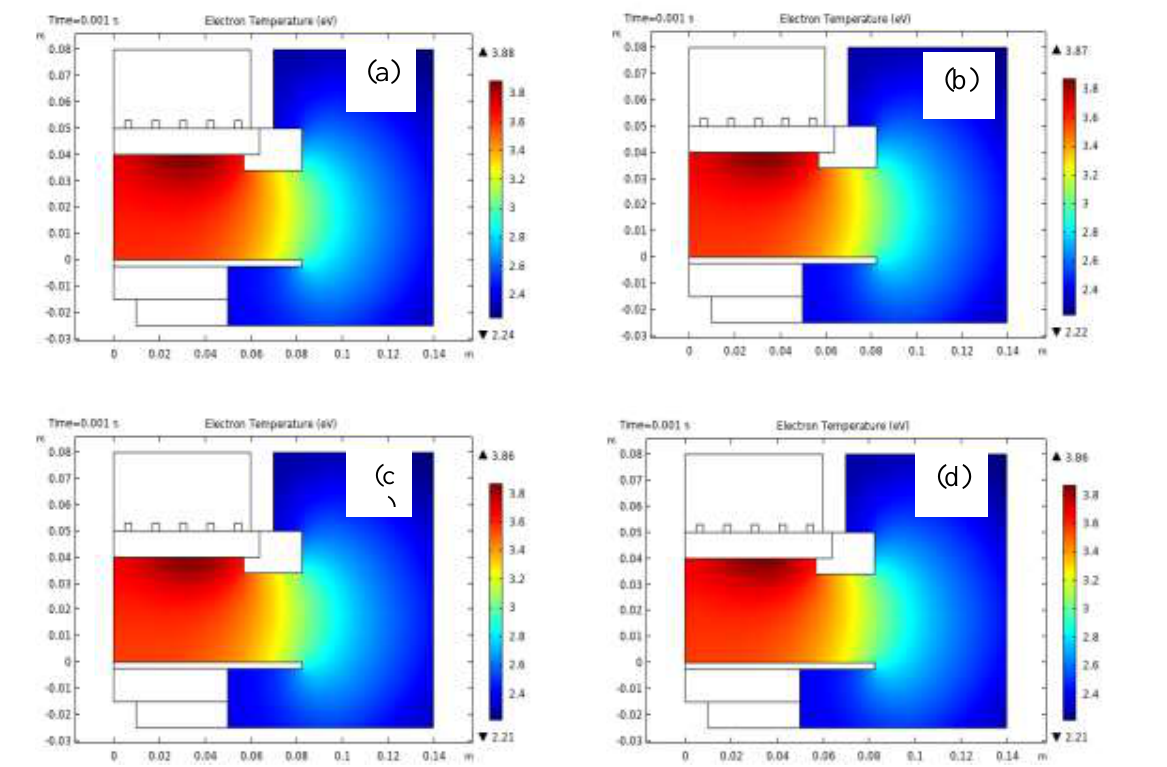
Figure 4: Electron temperature distribution in (eV) at different power input